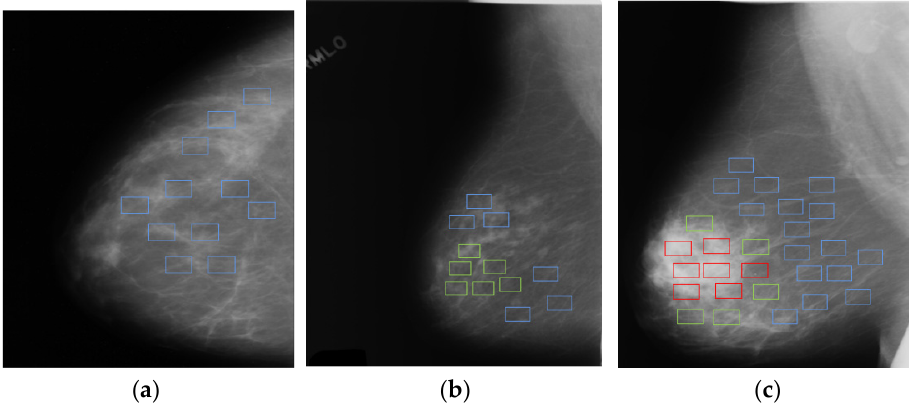
Figure 1. We show images of three types of breast disease lesions: ( a ) normal, ( b ) benign, and ( c ) cancerous. Specifically, the image (bag) consists of several patches (instances). The instances marked by blue rectangles denote normal lesion, green rectangles denote benign lesion, and red rectangles denote cancer. More importantly, the lesion level of the instance in each bag cannot exceed the lesion intensity of the bag.